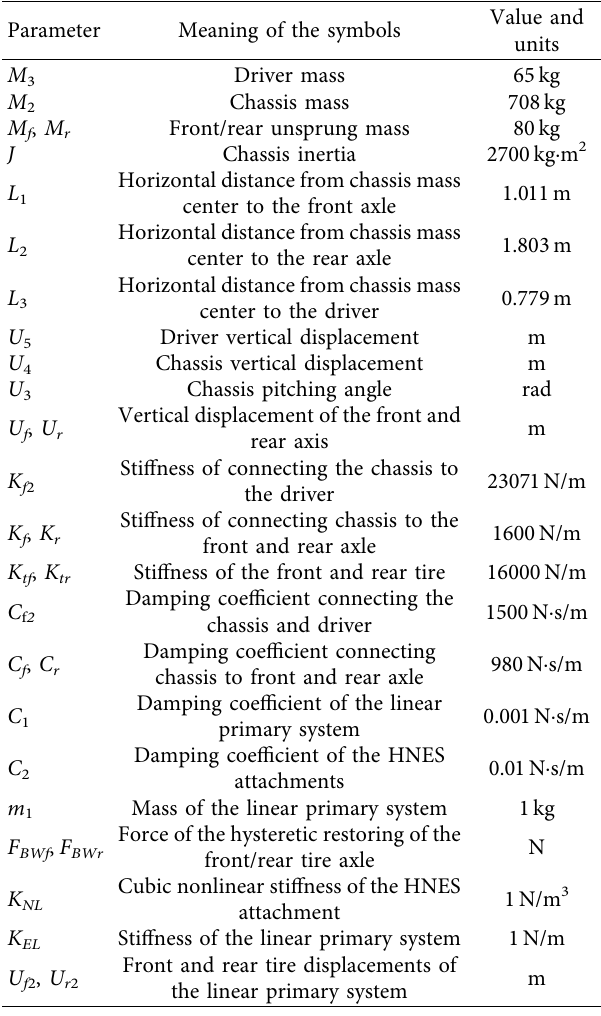
Table 2: Main parameters of half vehicle system coupling with the HNES